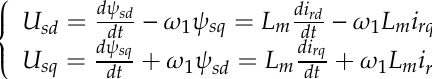
Figure 10. Overall control diagram of power priority control strategy. The grid-side converter implements dc voltage control, the rotor-side converter realizes the control of the power, and the guide vane opening control system of pump-turbine realizes the speed control of the unit. Since these control strategies are common, this article will not repeat them. The control process for each stage is shown as follows. Load ramping stage and load rejection stage: According to the full characteristic curve of the pump turbine, the speed of the unit in the load ramping stage and load rejection stage are maintained near the synchronous speed, and the power of the unit is constantly adjusted. According to the control strategy diagram and the DFIM model, the power and electromagnetic torque of the unit are controlled by the d-axis current of the rotor. The constant adjustment of d-axis current will lead to constant changes of unit speed. Since the purpose of the guide vane control system at this time is to maintain the unit speed at the synchronous speed, the guide vane opening is continuously adjusted, changing the flow and thus changing the output power of the pump turbine. In order to prevent a large change in speed when the power changes, a stepwise increase or decrease of the load is adopted, that is, the load is increased or decreased by 30 MW every 5 s until the power reaches the target value.